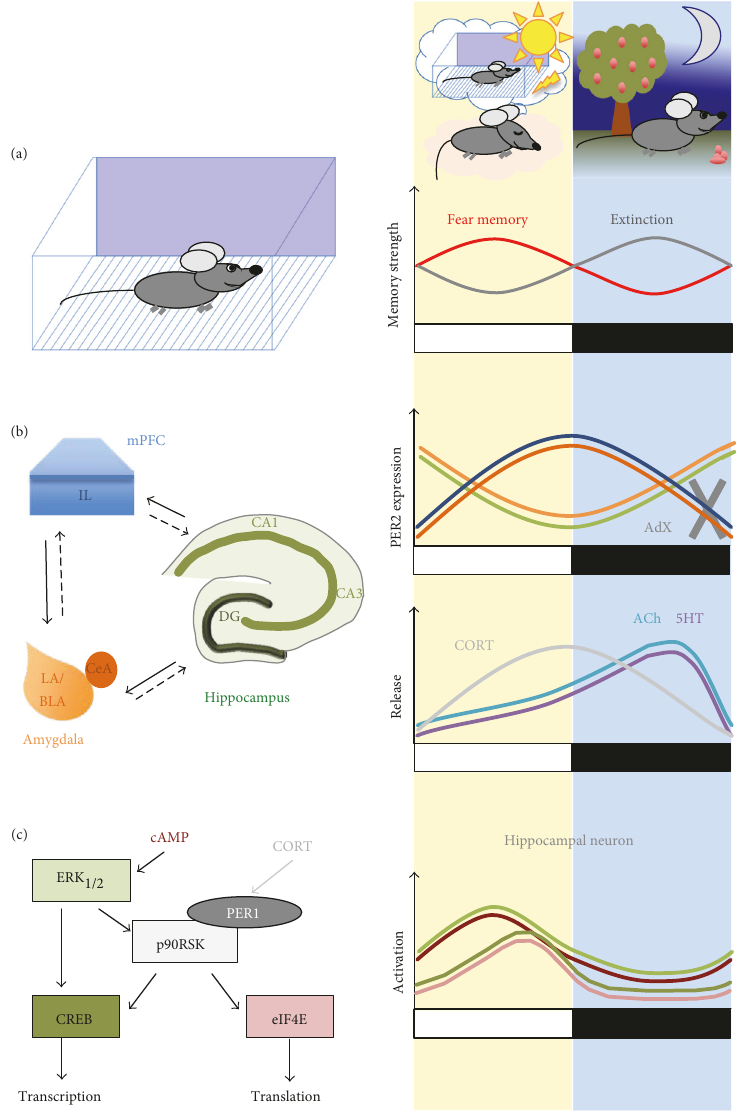
Figure 1: Overview of circadian fear memory system interactions. (a) On the behavioral level, fear memory strength is higher when fear conditioning and its retrieval took place during the inactive, light phase [51], while extinction memory is facilitated when training and testing took place during the dark, active phase [54]. On evolutionary aspects, this may relate to the increased signi fi cance of aversive events occurring during the inactive phase, when the animal usually retires to the nest. Further, the increased probability of posttraining sleep, which is required for memory consolidation, may strengthen fear memory acquired during the inactive phase. (b) On the brain circuit level, fear and extinction memory strength are determined by an interaction of the amygdala, hippocampus, and medial prefrontal cortex (mPFC). While cue associations are stored in the lateral and basolateral nuclei of the amygdala (LA/BLA), contextual information is processed by the hippocampal formation (DG: dentate gyrus; CA: Cornu ammonis, 1 – 3) [13, 16]. For extinction of fear memory, the infralimbic cortex (IL) is important in inhibiting conditioned responses, mediated trough the central amygdala (CeA) [22]. The expression of clock genes such as period (PER) 2 displays a circadian rhythm with di ff erent phase settings within the LA/BLA (light orange) and hippocampal subregions (light green) versus the CeA (dark orange) and IL (blue) [80 – 82]. Adrenalectomy (AdX) abolishes the circadian expression pattern of PER2 only in the CeA and the IL [80, 82], which correspond to circadian rhythms of corticosterone (CORT) plasma levels [95] depicted in the lower graph. In addition, fear memory consolidation strength is modulated by serotonin (5HT) and acetylcholine (ACh), which show circadian variations in amygdala and/or hippocampal tissue levels as well [112, 117]. (c) On the molecular level, it has been shown in hippocampal neurons that di ff erent components of the MAPK pathway display a circadian activation pro fi le, with peaks during the light phase for the second messenger cAMP (dark red), the kinase ERK1/2 (light green), the transcription factor CREB (dark green), and the protein translation initiation factor eIF4E (light red) [90, 91, 93]. Moreover, the nuclear translocation of p90RSK, a kinase that activates CREB and modulates translation, is regulated by the clock protein PER1, thereby modulating transcriptional activation of CREB-dependent downstream proteins [90]. PER1 expression levels are further regulated by corticosterone signaling, adding a further level of stress and circadian systems interactions